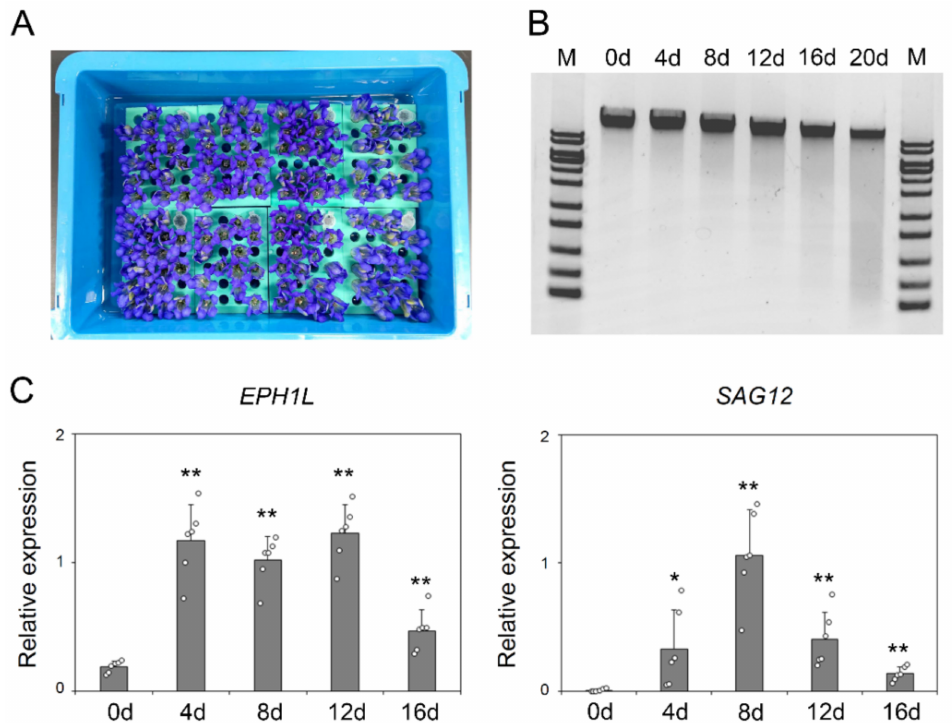
Figure 3. Dark-induced senescence of “Albireo” corolla at stage 4. ( A ) The state of “Albireo” corolla before the start of dark-induced senescence treatment. The cover is opened for the photograph. ( B ) Image of the agarose gel electrophoresis of the genomic DNAs of “Albireo” corolla from before the start of the dark-induced senescence treatment until the 20th day after the start of the treatment (every 4 days). ( C ) The relative expression levels of EPH1L and SAG12 determined by quantitative reverse transcription polymerase chain reaction ( n = 6). Asterisks indicate statistically significant differences between 0 d and 4–16 d as demonstrated by Student’s t -test (* p < 0.05, ** p <